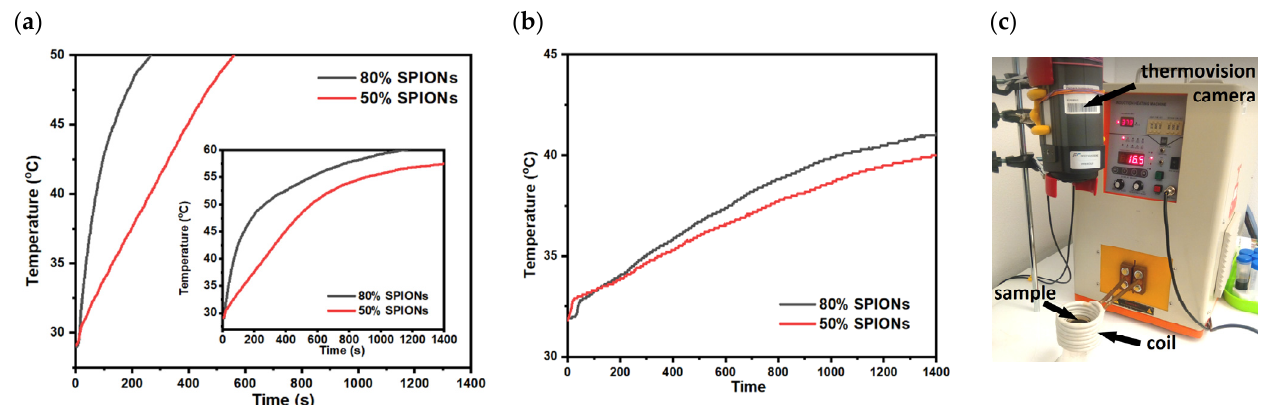
Figure 12. Temperature of nanocomposites magnetization with different concentrations of SPIONs and solvent, respectively, ( a ) 5 mg mL − 1 in DI water, ( b ) 10 mg mL − 1 in solution in cultivation medium, and ( c ) magnetic hyperthermia setup.